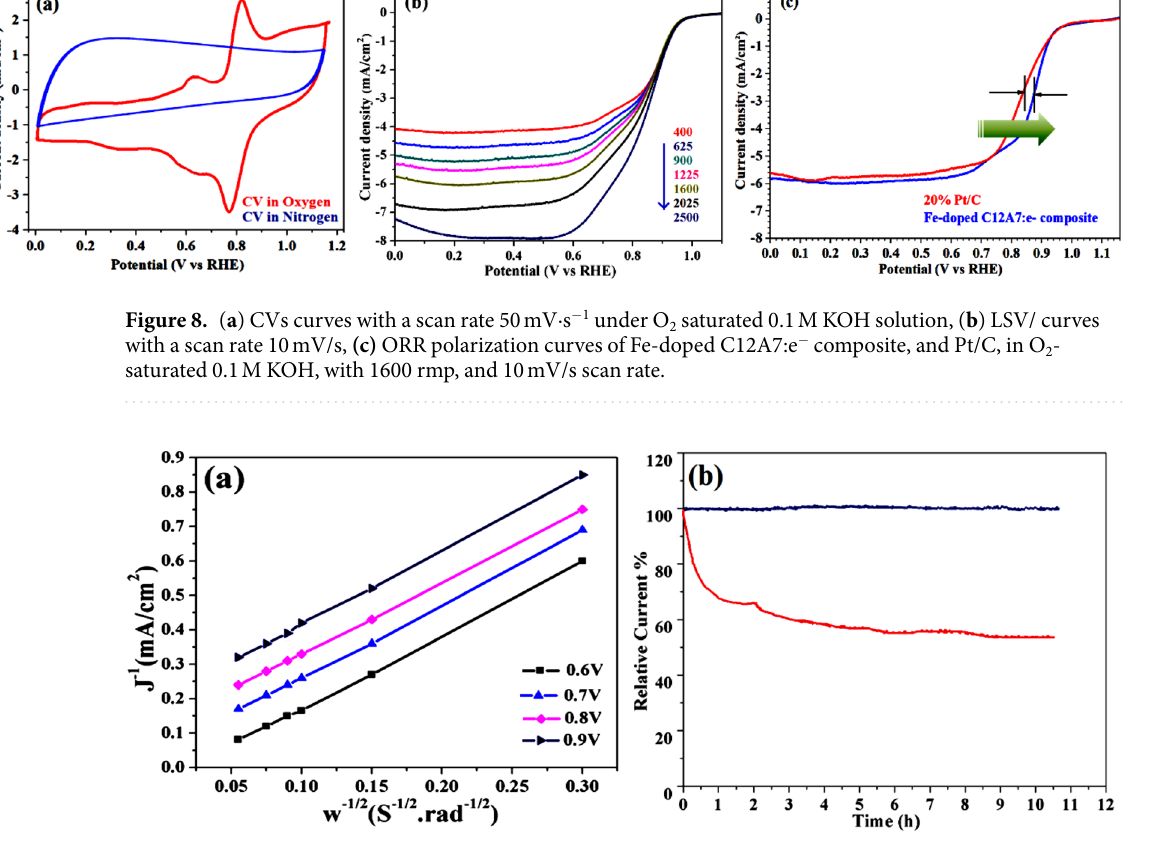
Figure 9. ( a ) At different potentials K-L plots of Fe-doped C12A7:e − composite (doping level, x = 1), and ( b ) Chronoamperometry curves of 20% Pt/C and synthesized electrocatalysts measured at 1600rpm.